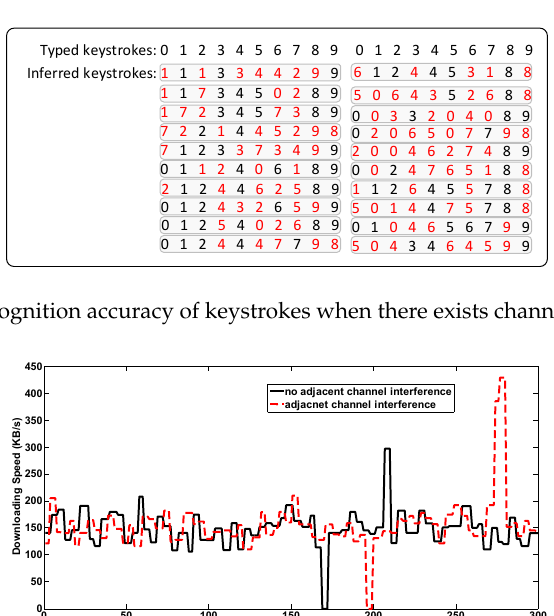
Figure 13. Recognition accuracy of the unlock pattern when there exists channel interference.